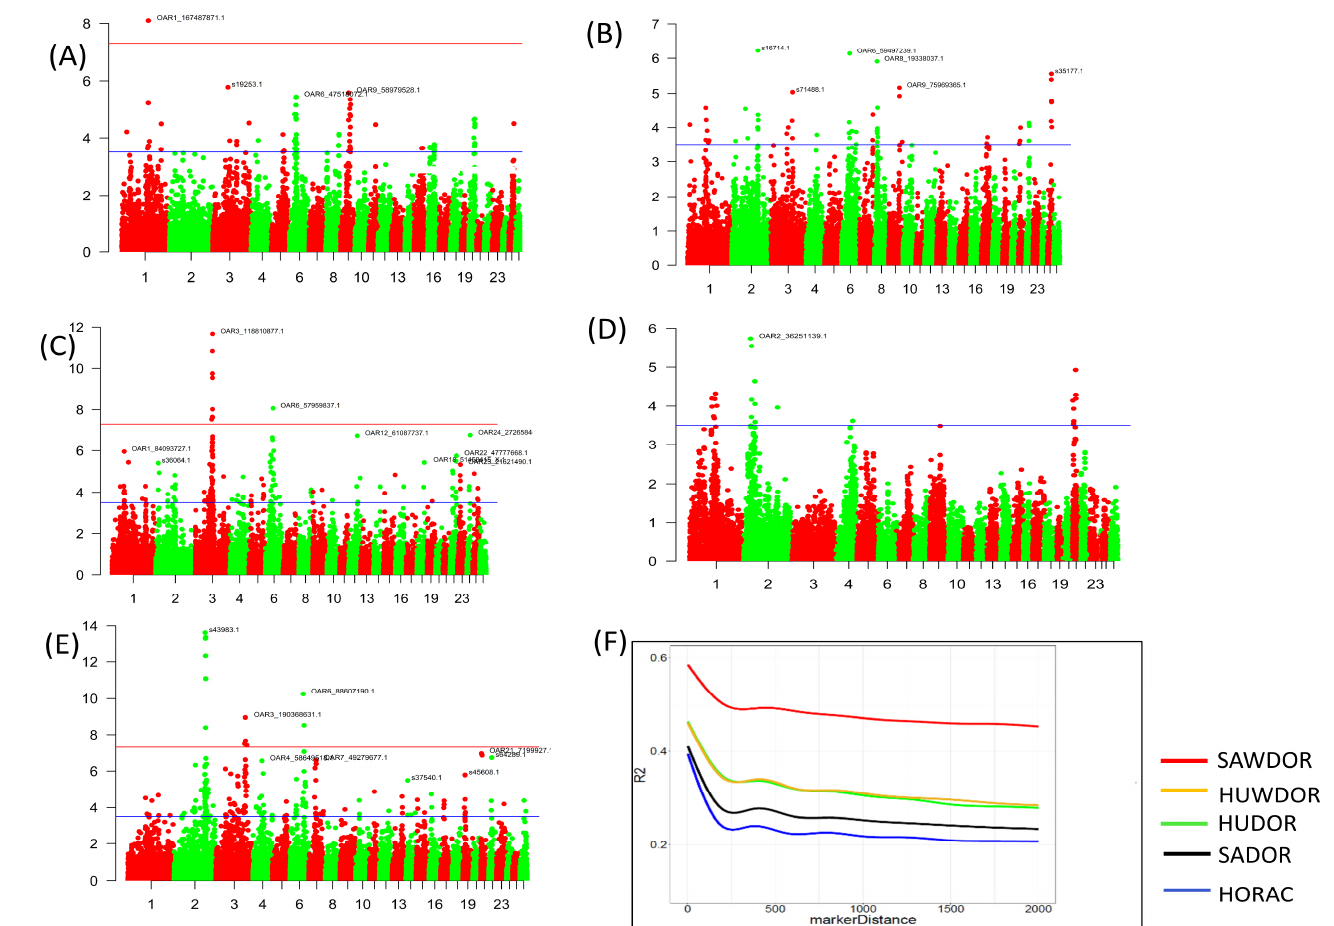
Figure 2. Genome-wide distribution of iHS values for ( A )—HUDOR, ( B )—HUWDOR, ( C )—SADOR, ( D )—SAWDOR, and ( E )—HORAC sheep breeds. x-axis of Manhattan plots represents Autosome chromosome numbers, The red line represents the top 0.001 percentile distribution of iHS values, while the blue line represents the top 0.01 percentile, SNPs are annotated at p value of 0.00001. ( F ) Genome-wide linkage disequilibrium decay against marker distance in each population.